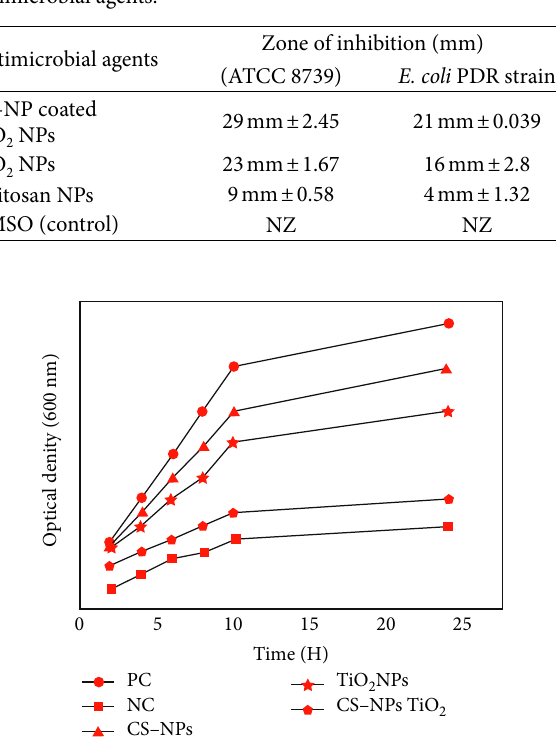
Figure 10: Growth kinetics of E. coli at the MIC concentrations for 24 hours. CS-NPs coated TiO efficiently.